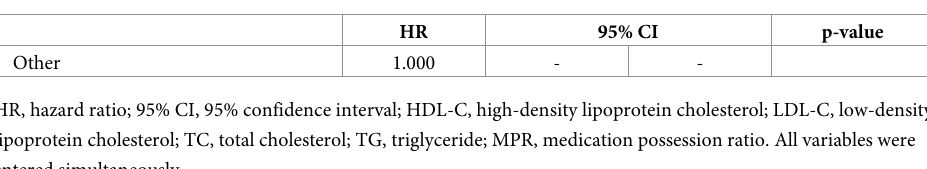
PLOS ONE | https://doi.org/10.1371/journal.pone.0250716 April 23,